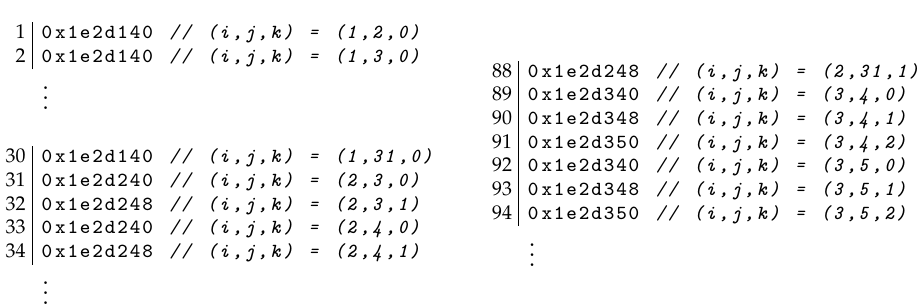
Figure 3. Source code of the cholesky kernel.